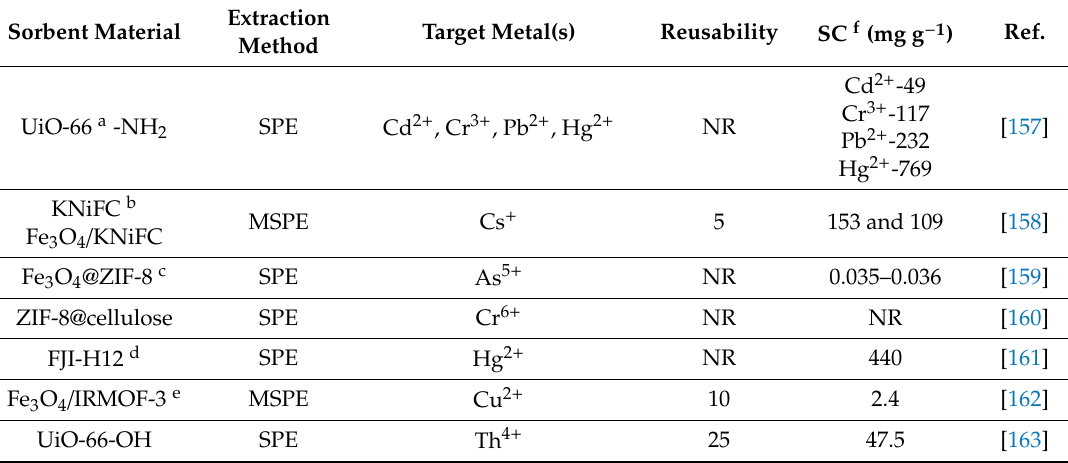
Table 6. MOF sorbent materials for metal